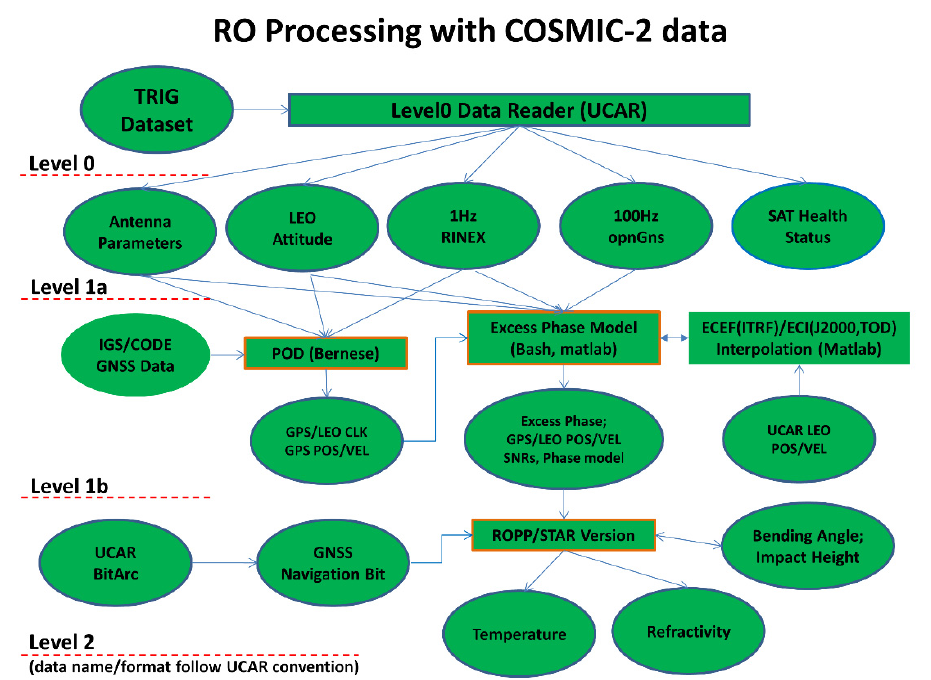
Figure 2. STAR RO COSMIC-2 processing procedure. Different data product levels (level 0 to level 2) are also shown using the UCAR naming convention.